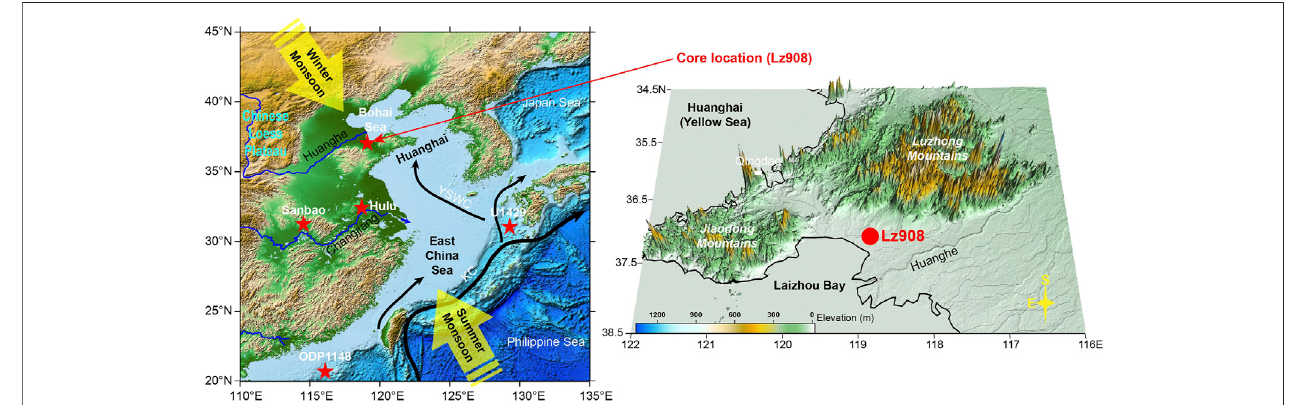
FIGURE 1 | Location, environmental system, and study site (Lz908) and reference sites mentioned in the text. KC, Kuroshio Current; YSWC, Yellow Sea warm current; EASM, East Asian summer monsoon. The base map data was generated using the open and free software DIVA-GIS 7.5 (http://www.diva-gis.org/).